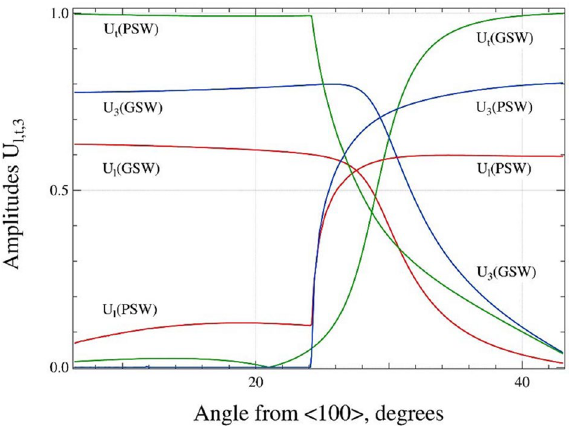
Figure 2. The comparison of the azimuthal dependencies of the normalized longitudinal U l (red), transversal U t (green) and normal U 3 (blue) amplitudes for the GSW and PSW modes, calculated at using a software IGOR version 6.34A, https ://www.wavem etric s.com/produ cts/igorp ro).